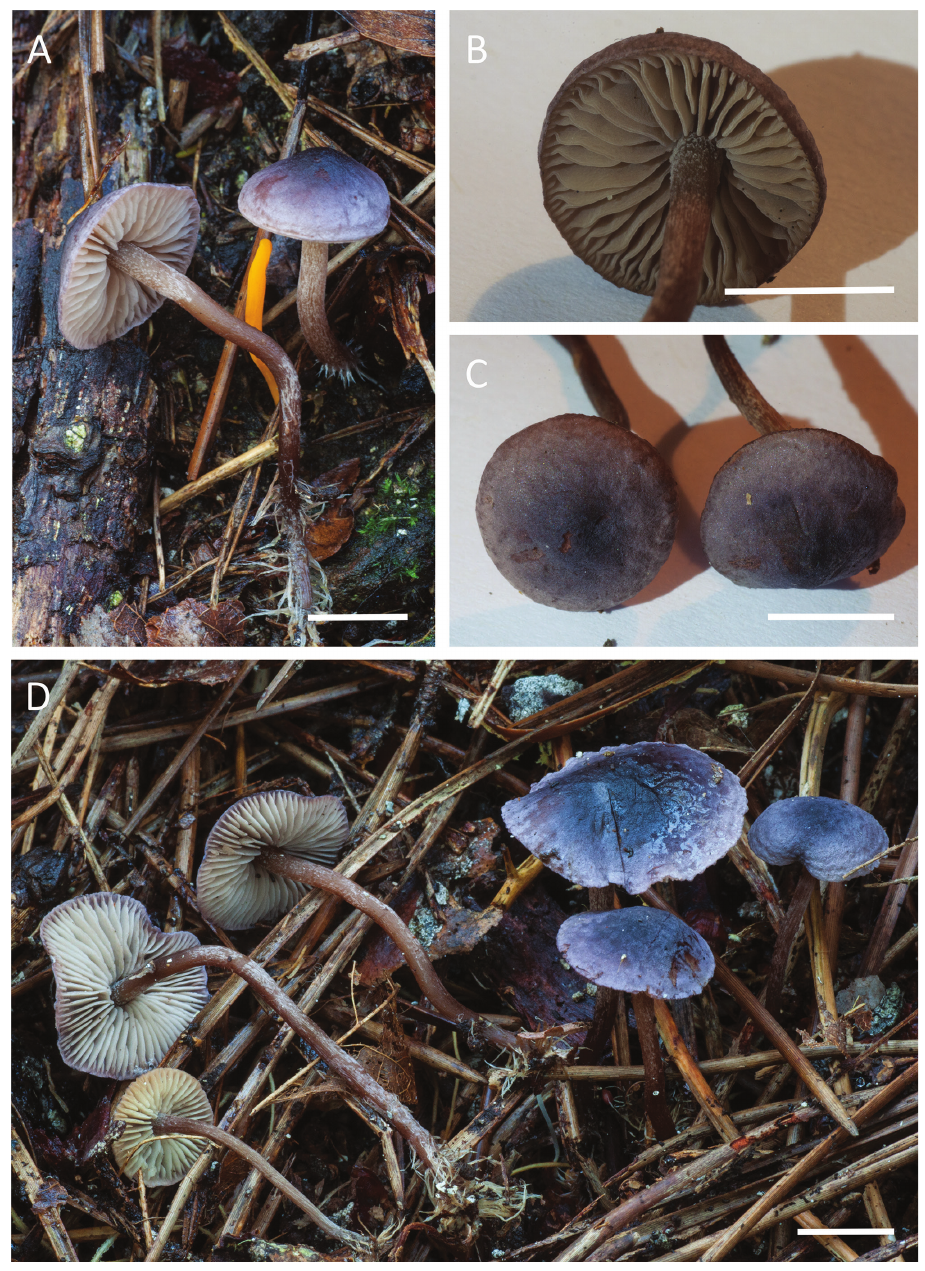
Figure 1. Pseudobaeospora cyanea A, D basidiomata B gills C pileus. Scale bars: 1 cm. (photos D.